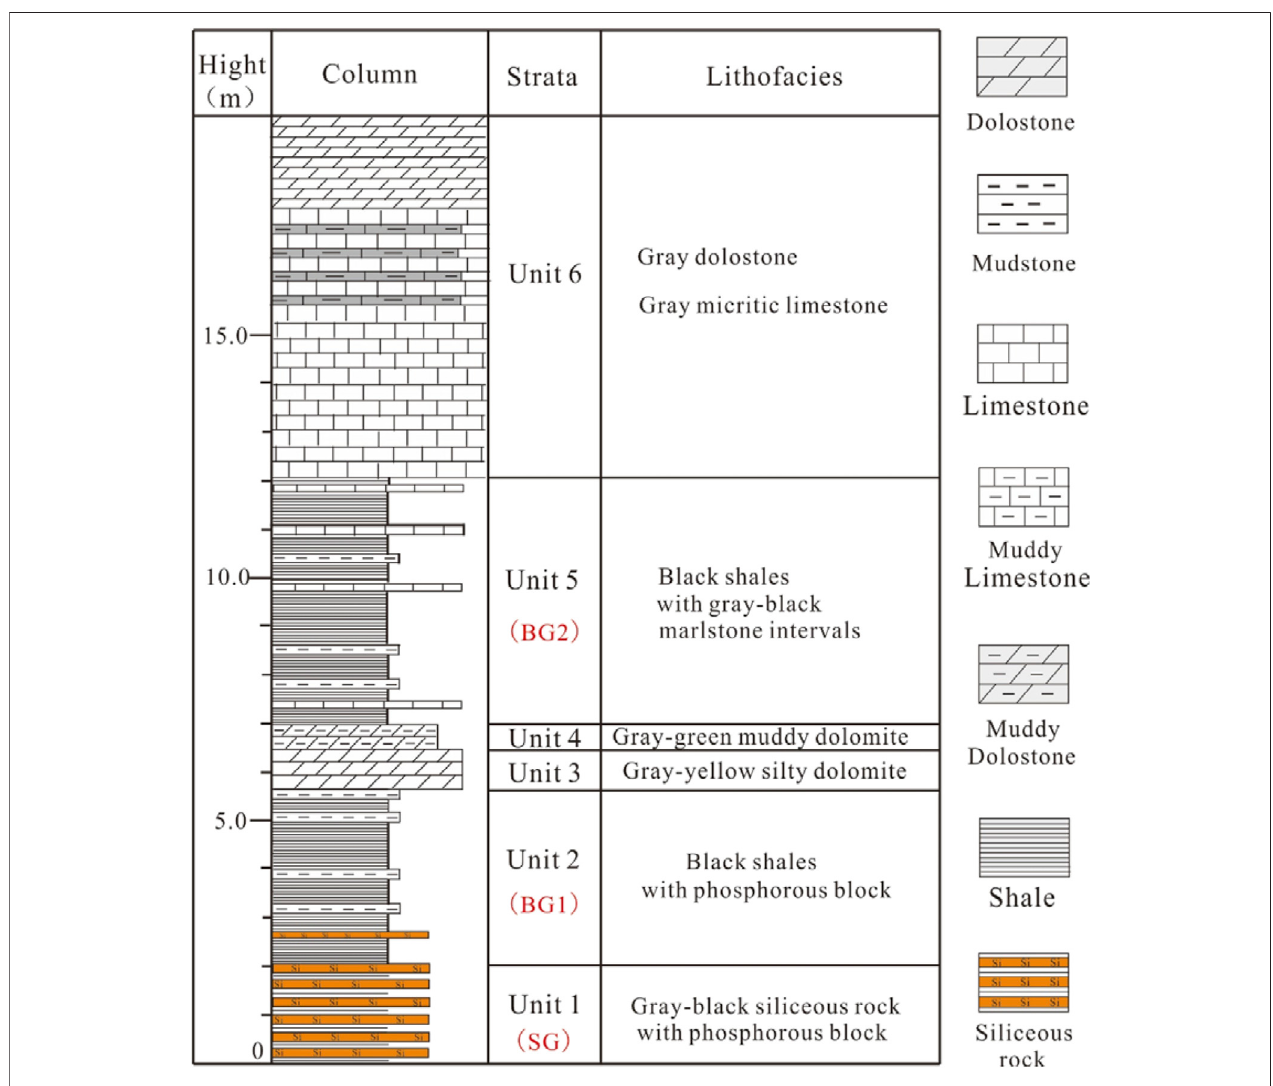
FIGURE 2 | Lithostratigraphic columns of the Yutixi outcrop in the Aksu area.